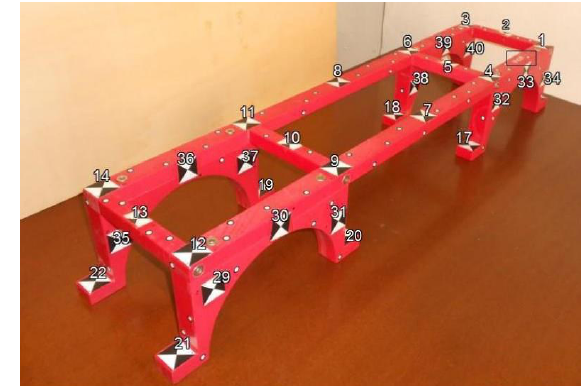
Figure 4. Calibration frame (I)